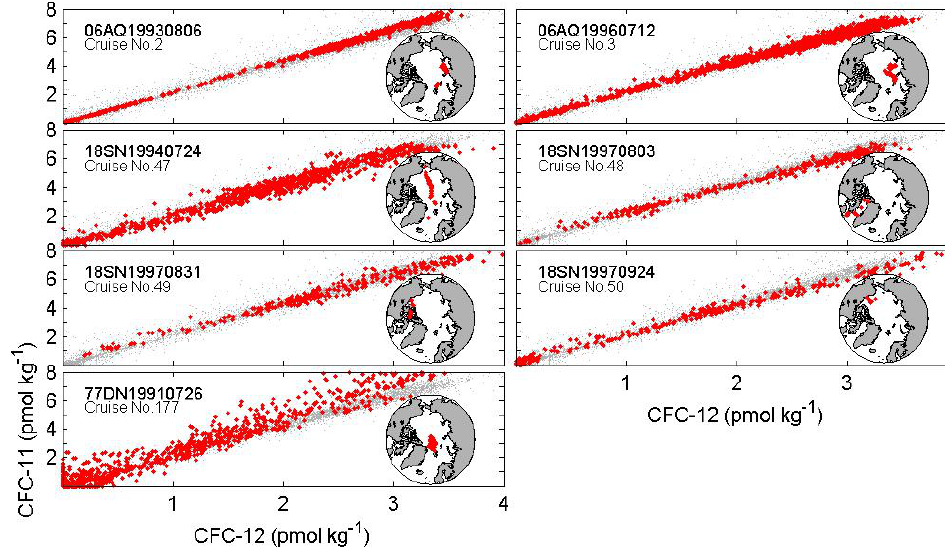
Figure 15. CFC-11 vs. CFC-12 for the Arctic Ocean data. See Fig. 11 for specifications.